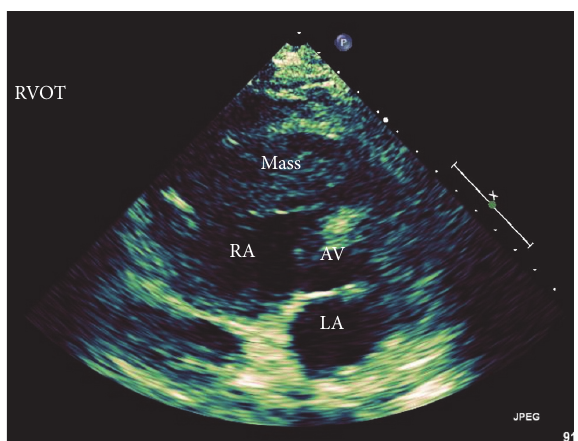
Figure 3: Cardiac MRI image showing a large lobulated heteroge- nous mass in the right ventricle which limited the opening of the tricuspid valve.